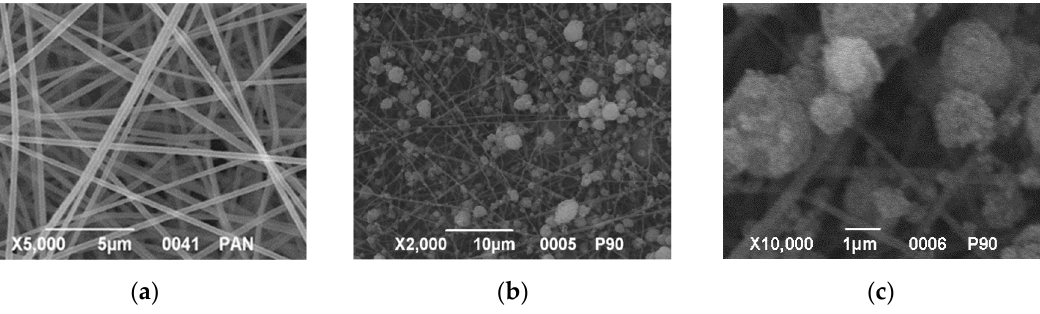
Figure 3. Scanning electron microscope (SEM) micrographs of ( a ) PAN, ( b , c ) PAN_TiO 2 membranes.